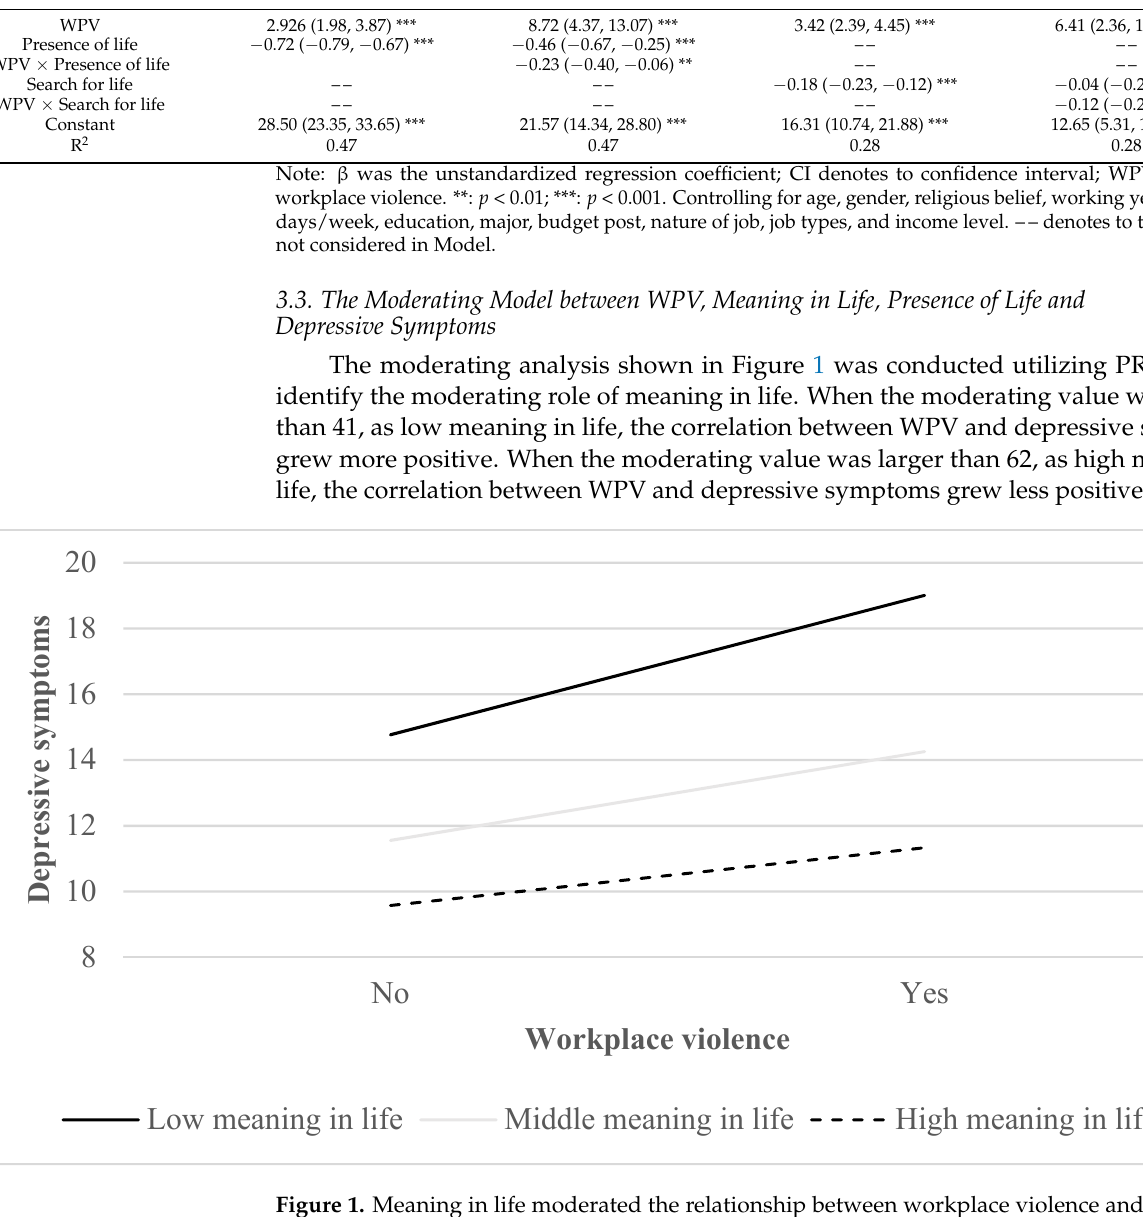
Figure 2. Presence of life moderated the relationship between workplace violence and depressive symptoms among primary health care professionals. In summary, the results showed that there were stronger associations between WPV and depressive symptoms with low presence of life than that with high presence of life. It meant that primary healthcare professionals with higher presence of life would soften their levels of depressive symptoms than those with lower presence of life. 4. Discussion The current study aimed to investigate the relationship between WPV and depressive symptoms and the moderating role of meaning in life on the relationship between WPV and depressive symptoms among primary healthcare professionals in China. Primary healthcare professionals who experienced WPV had more depressive symptoms in China. As expected, meaning in life, as a protective moderator, accounted for the as-mentioned relationship, and only presence of life moderated the relationship. The results in the present study are as follows: 15.7% of primary healthcare profes- sionals experienced WPV by patients or their relatives, 14.9% of primary healthcare